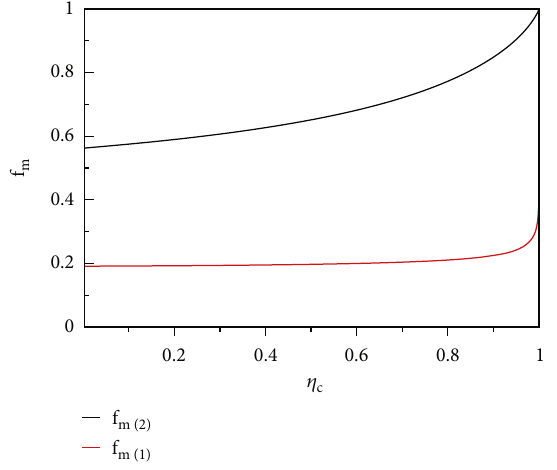
Figure 9: The relative period ( τ of optimization criteria versus Carnot e ffi ciency.